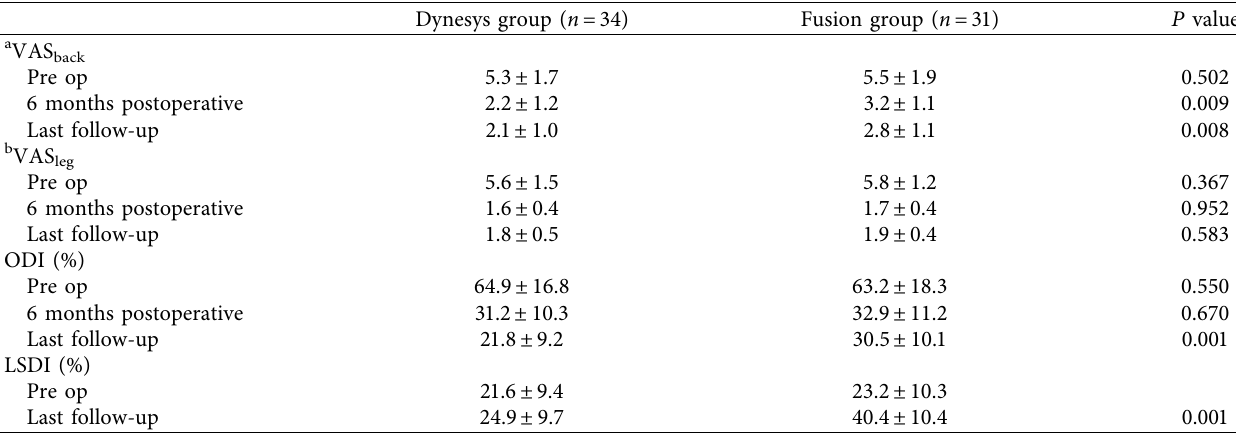
Table 2: Clinical outcomes